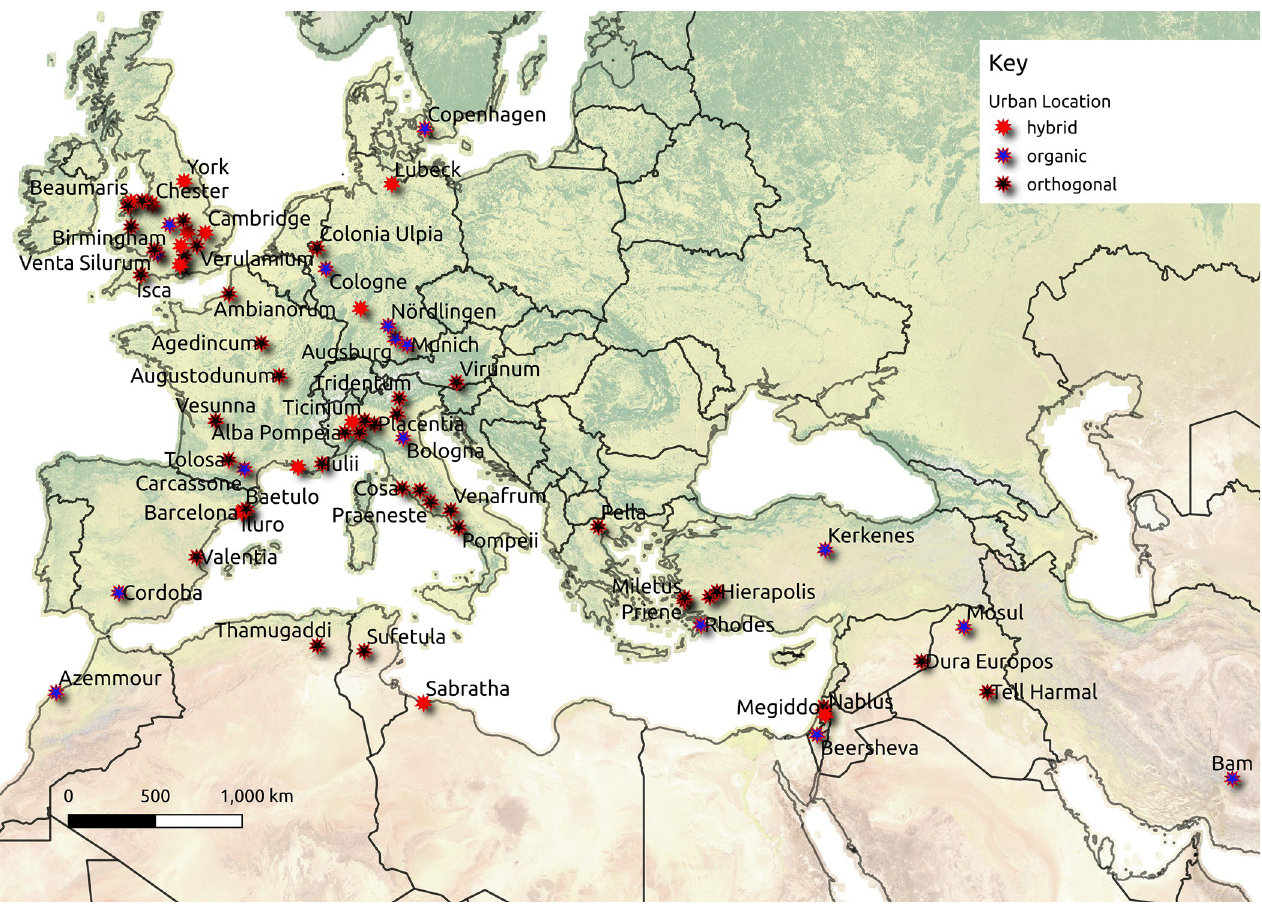
Fig 1. Urban sites collected for this article. Background map data courtesy of Natural Earth (https://www.naturalearthdata.com/).